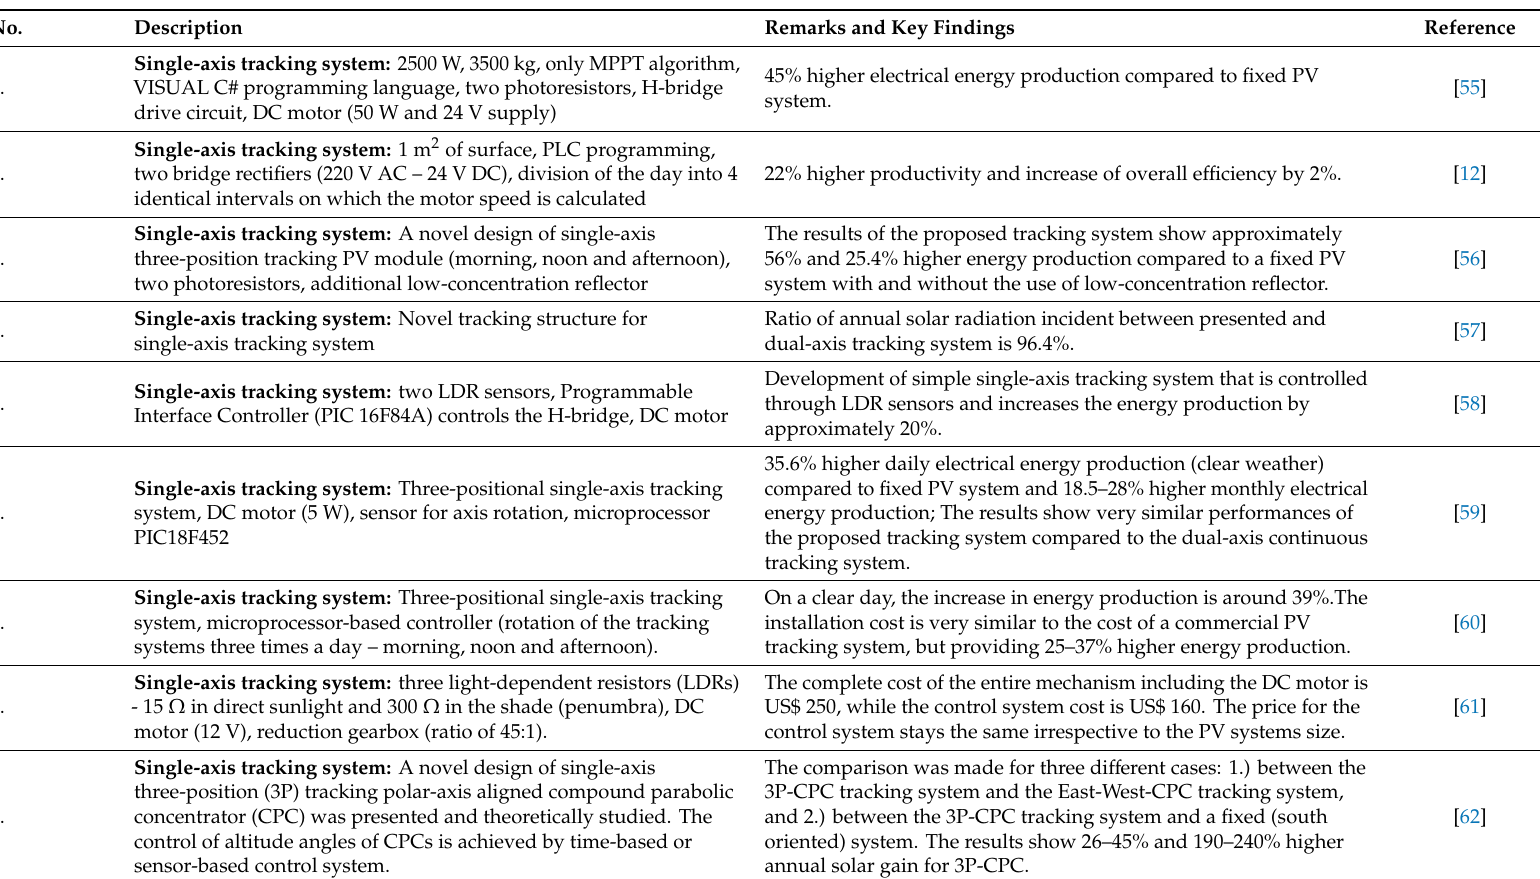
Table 1. Summary of some important studies focusing on single- and dual-axis PV tracking